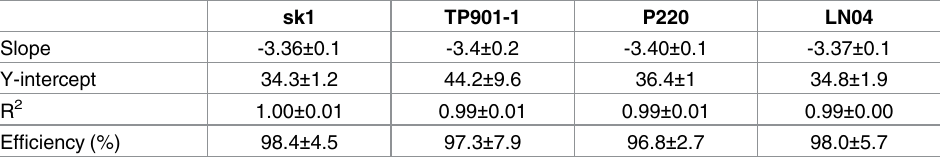
Table 2. Performance of individual qPCR assays.